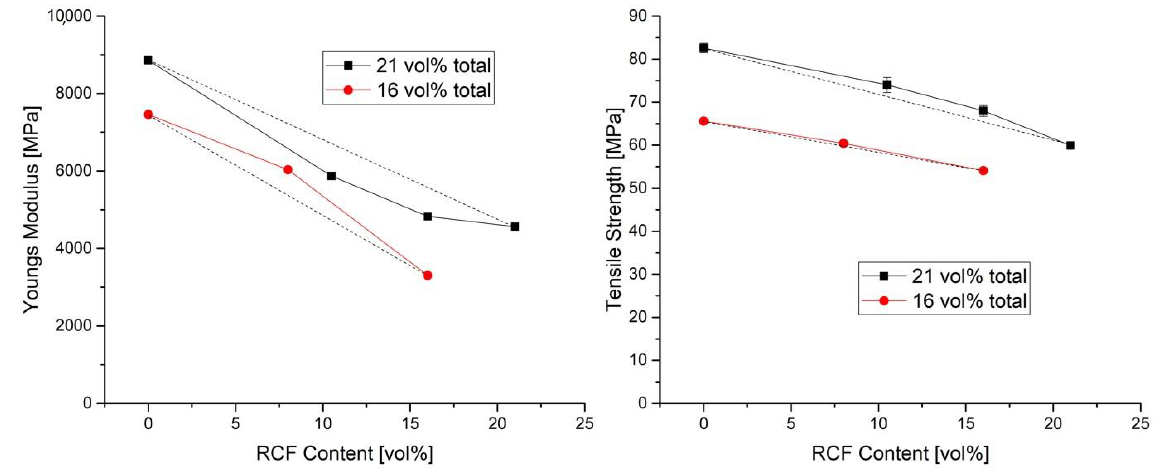
Figure 2. Youngs Modulus ( left ) and Strength of tensile tests ( right ) at 16 and 21 vol% fibers with different type ratios and reference compounds.